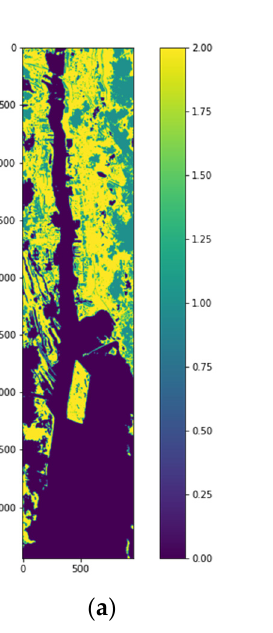
Figure 10. Confusion matrices for classification of HSI2 Image 1 into 3 classes for a batch size of 1500 using 3 PCA bands with the three types of scaling methods ( a ) normalization scaling (ns), ( b ) maximum scaling (ms), ( c ) scaling (sc). The three classes are indicated as W—water, C—clouds, L—land.